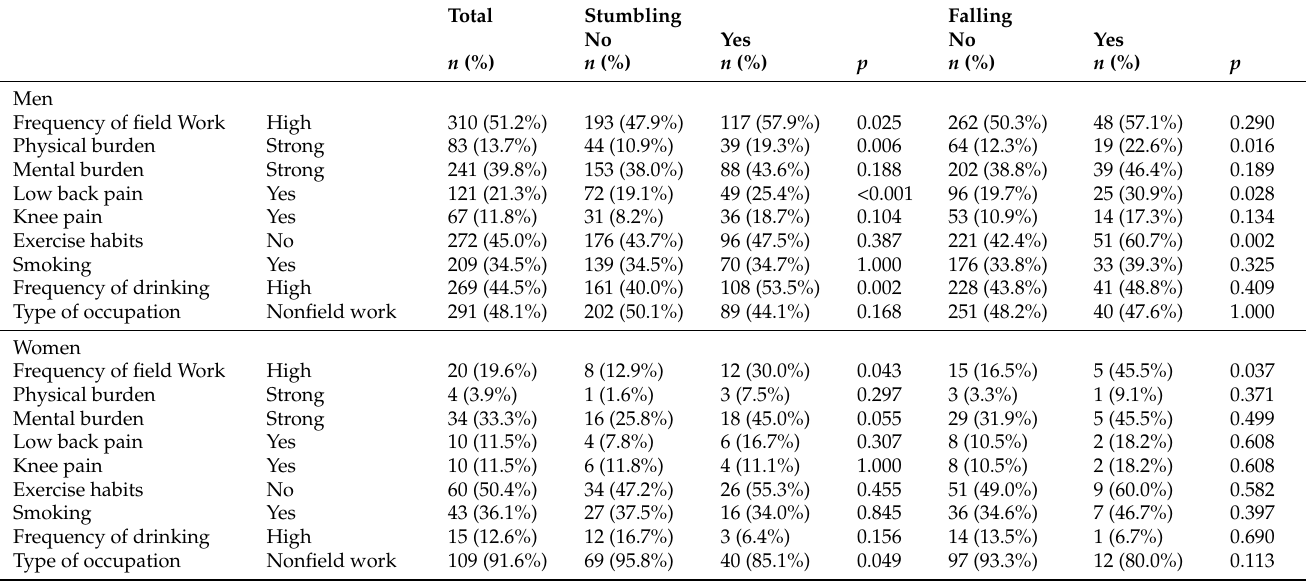
Table 4. Distribution of characteristics of categorical variables grouped according to the